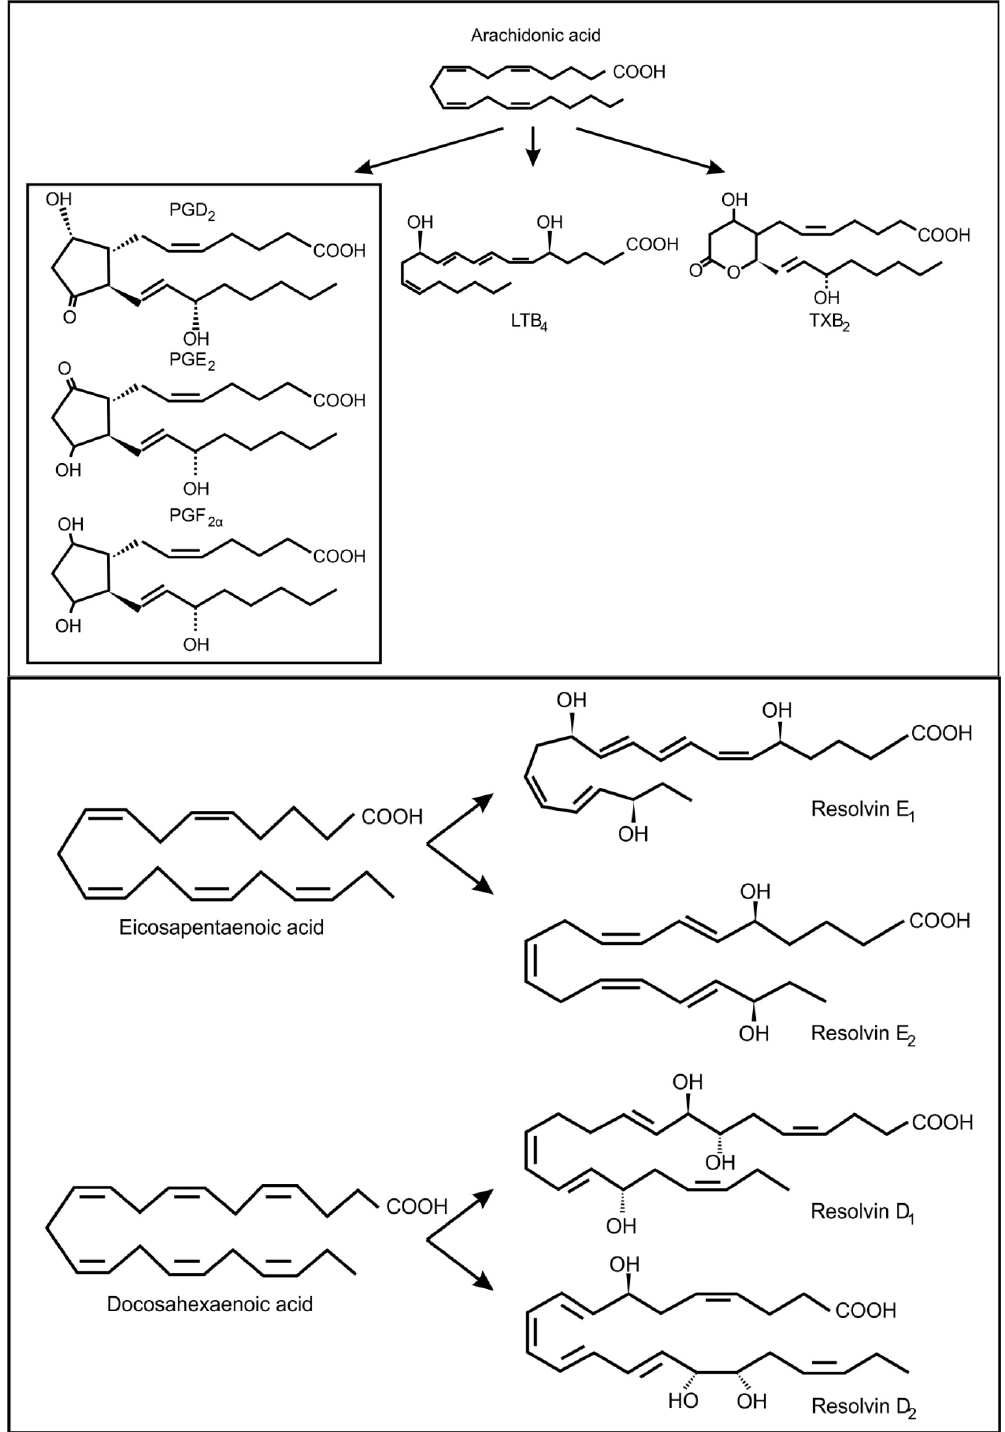
Figure 3. Oxidized fatty acids derived from arachidonic acid as well as from eicosapentaenoic acid and docosahexaenoic acid, involved in inter-kingdom signaling between fungi and